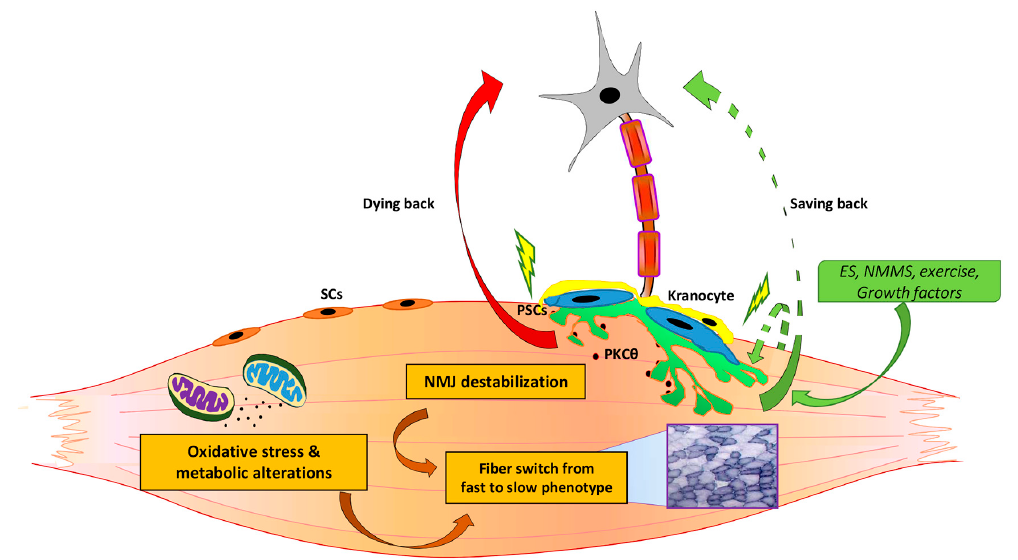
Figure 2. A summary of the relevant changes, cells, and signaling involved in the pathogenesis of ALS and aging. Morphological and functional alterations of the neuromuscular junction (NMJ) represent part of the earliest signs of aging and ALS. NMJ development, remodelling, and stability is also influenced by di ff erent signals and cells, including PSCs and kranocytes. According to the dying back hypothesis, and based on studies regarding how skeletal muscle interventions can influence NMJ, further studies should be encouraged to verify whether combinatorial approaches on different cell and tissue targets induce more satisfactory therapeutic benefits and to define whether a sort of “saving back” approach can be promoted to preserve NMJ integrity, to delay motor neuron impairment, and to counteract muscle-nerve dysfunction.